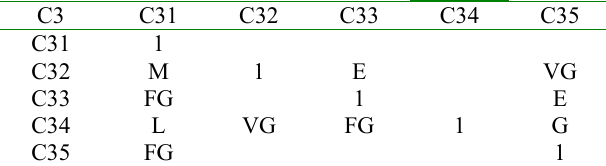
Table 13. Linguistic evaluation matrix of DM3 for C3 sub-criteria